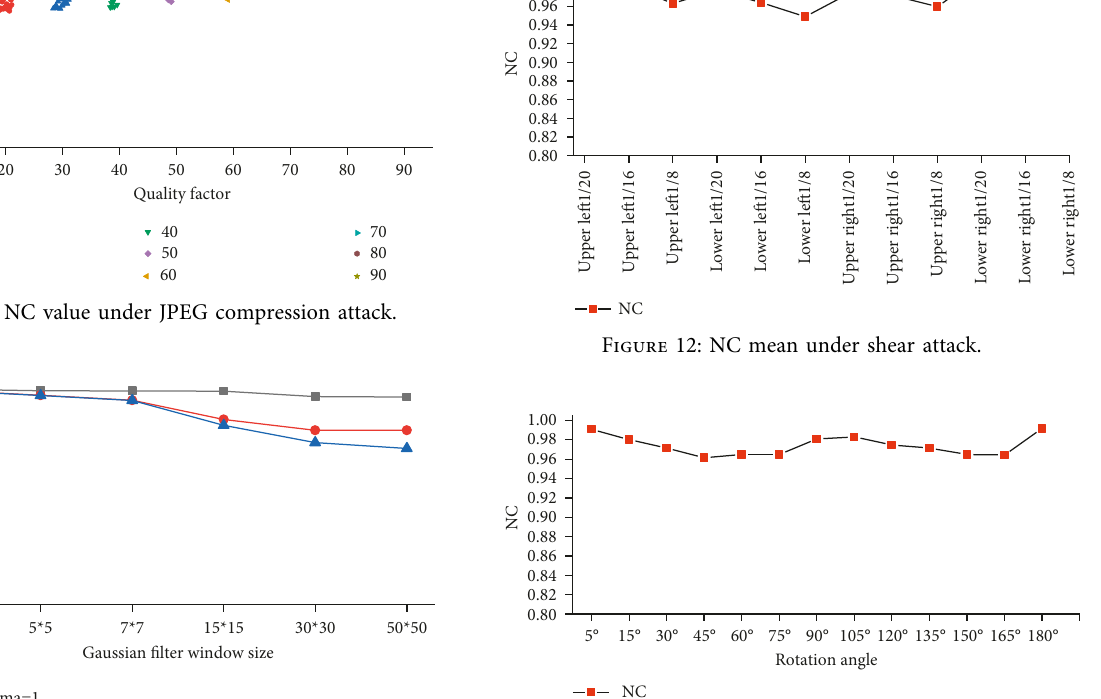
Figure 13: NC mean under rotation